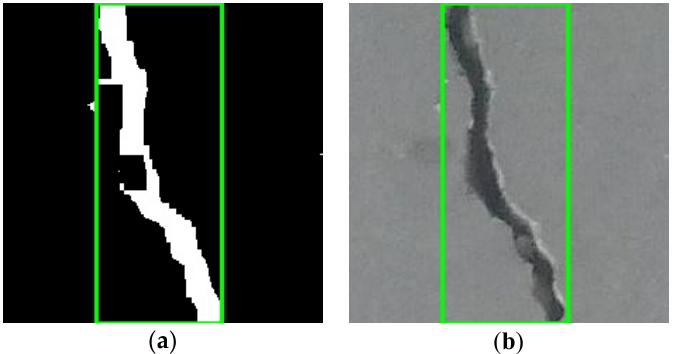
Figure 3. Results of connected component labeling of ( a ) Figure 2b; ( b ) a significant portion of the crack in Figure 1a.